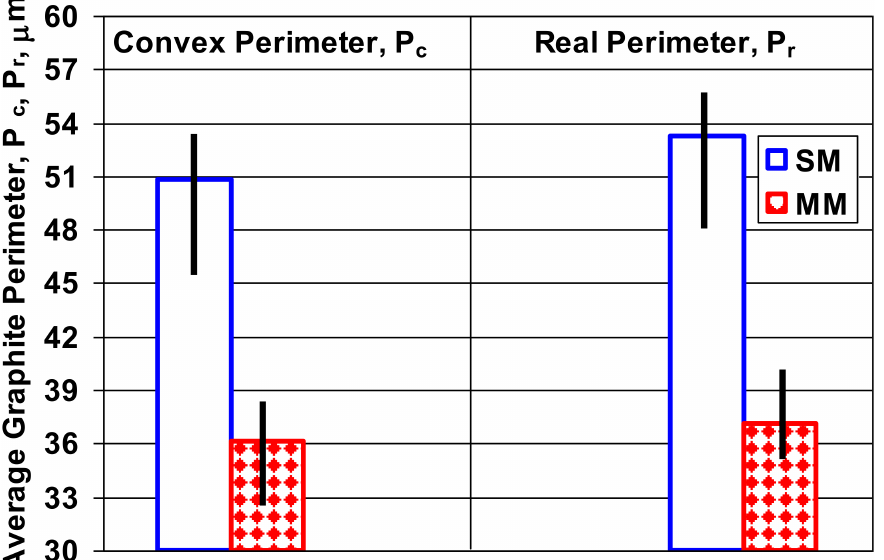
Figure 6. Average convex and real perimeter values of the graphite particles in the 6–15 mm wedge casting section size solidified in the sand and metal molds.